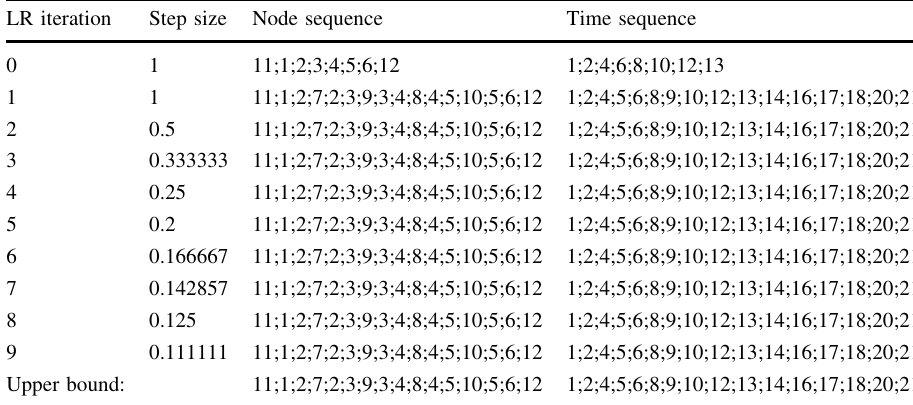
Table 6 The evolution of path node sequences and path time sequences for the basic example